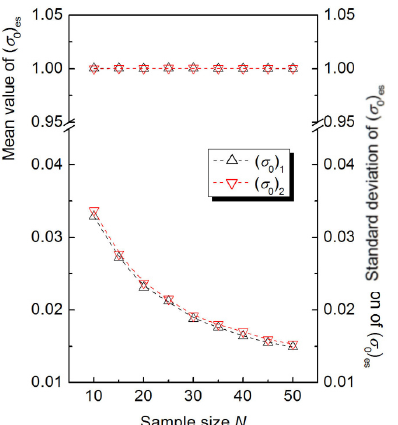
Fig. 9 Sample-size dependence of the mean value and the standard deviation of method and the LS method (